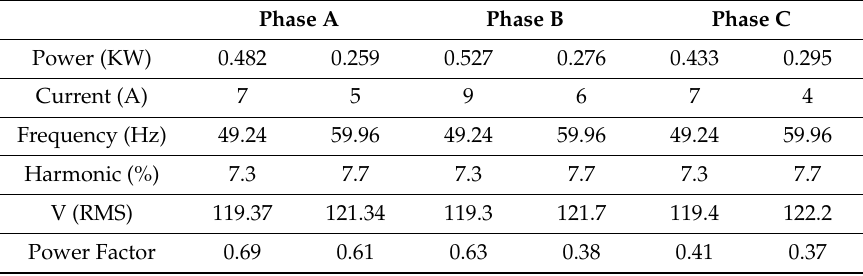
Table 3. Measured values of the induction motor and VFD output voltage.